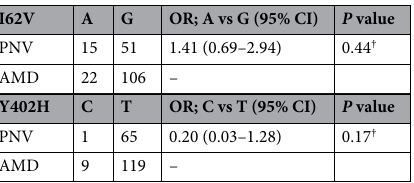
Table 5. Odds ratio of each allele. CFH complement factor H, OR odds ratio, CI confidence interval. † Fisher’s exact